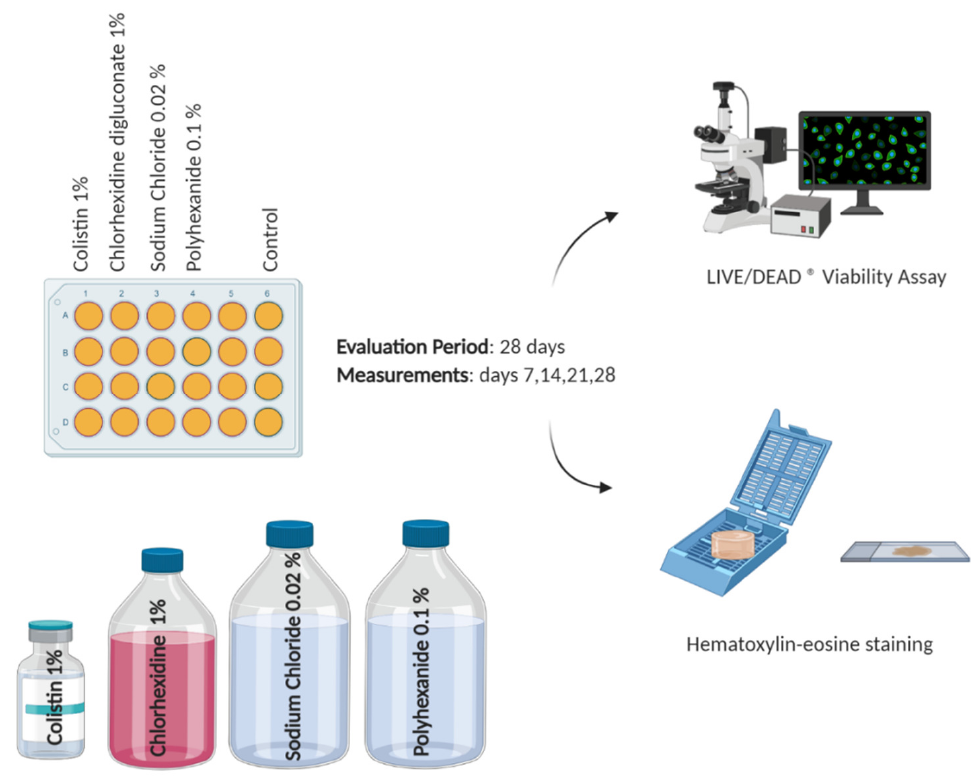
Figure 2. Schematic representation of the antibiotic/antiseptic test. Created with BioRender.com .